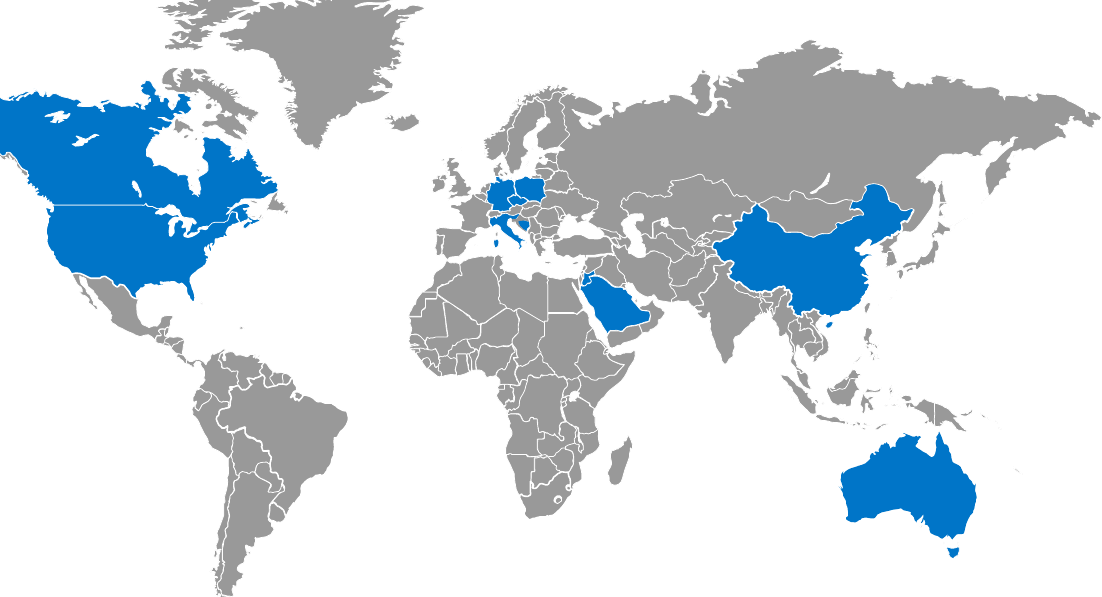
Figure 2. Countries involved in the studies are shown in blue on the world map; they are Australia, Bosnia and Herzegovina, Canada, China, the Czech Republic, Germany, Italy, Jordan, Poland, Saudi Arabia, and the U.S.A.